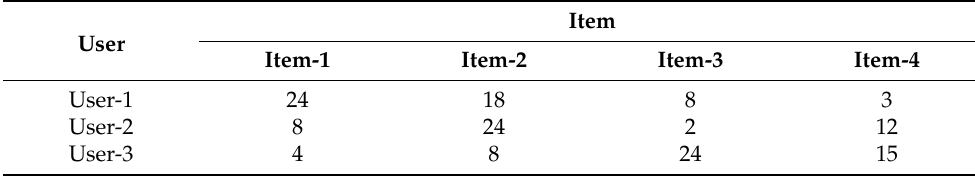
Table 4. The results of the weighted